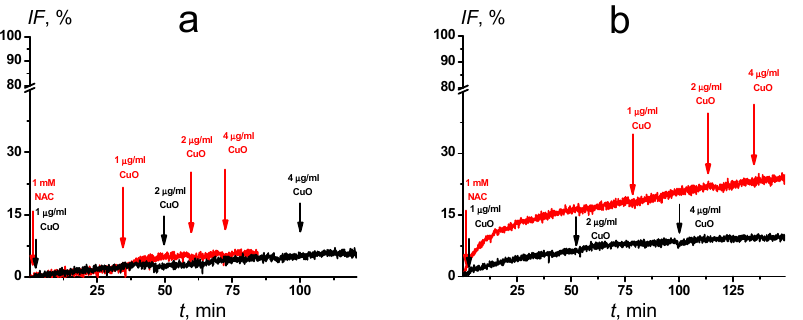
Figure 5. Time dependence of relative fluorescence of calcein ( IF , %) leaked from POPC ( a ) and POPG ( b ) vesicles. CuO NPs alone (black curves) or in combination with 1 mM NAC (red curves) were added to the liposomal suspension at indicated concentrations (arrows). One representative experiment out of three independent measurements is shown.